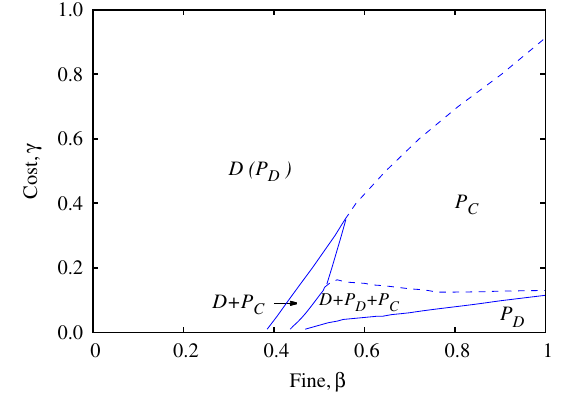
FIG. 4. Representative spatial evolution of the four competing strategies. Depicted are snapshots of the square lattice, as obtained for β ¼ 0 . 8 , γ ¼ 0 . 36 , and r ¼ 3 . Nonpunishing (pun- ishing) cooperators are depicted in light blue (dark blue), while nonpunishing (punishing) defectors are depicted in light red (dark red). From a random initial state (a) both cooperative strategies start vanishing quickly (b). The only chance for cooperation to survive is if a lucky P seed starts growing in the sea of D C players, as indicated in (c) by a white circle. It turns out, however, that P players, surrounded by a thin active layer of D players, C can rise to complete dominance over time, as shown in (d) – (f) (the final state, where only P remain after 6000 MCS, is not C shown). The linear size of the lattice is L ¼ 800